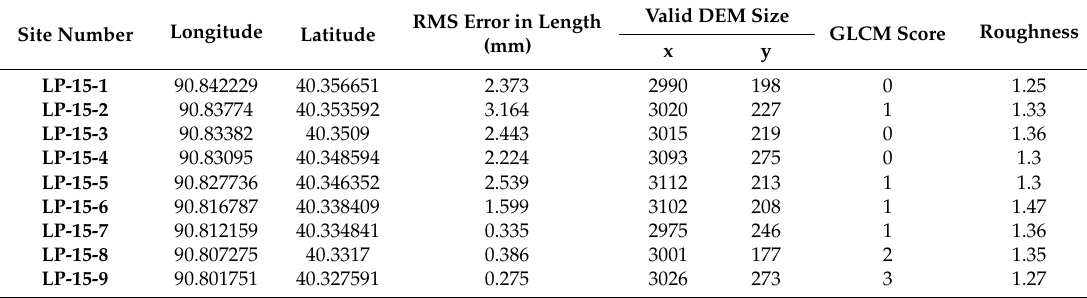
Table 1. Details of all